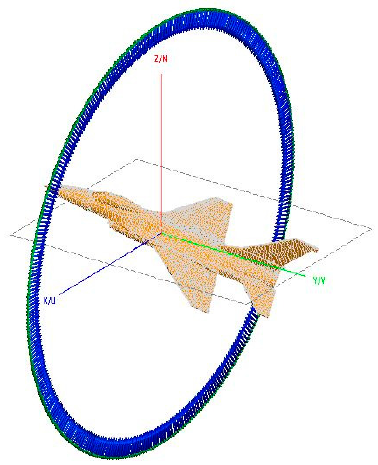
Figure 14. Target geometry of the F16 aircraft CAD model.